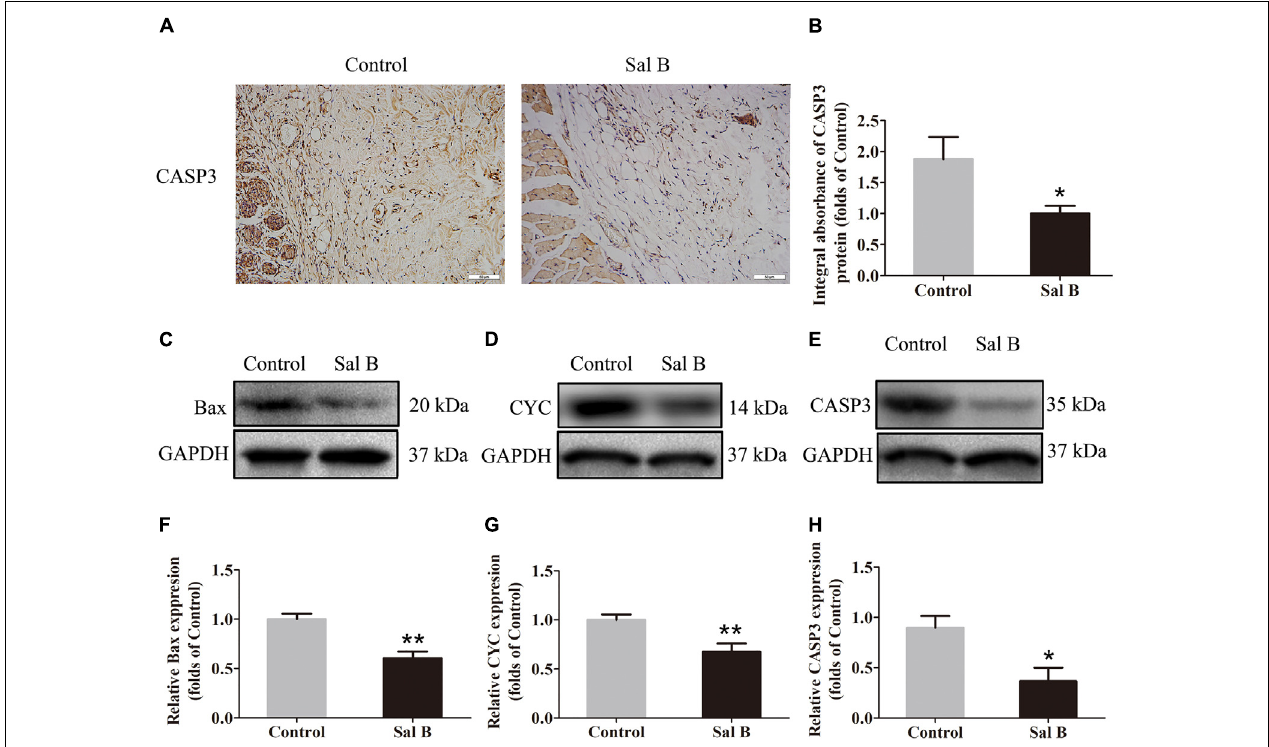
FIGURE 3 | Sal B inhibits apoptosis in random skin flaps. Rats were killed and the samples in middle part of flap area II were harvested for analysis on post-operative day 7. (A) Caspase 3 expression in skin flaps of the Control and Sal B groups, evaluated by IHC (original magnification: 200 × ; scale bar: 50 µ m). (B) Histogram of optical density values of Caspase 3 expression by IHC. (C – E) Western blotting for protein levels of Bax, CYC, and caspase 3, respectively, corrected by GAPDH as internal control. The gels have been run under the same experimental conditions. The original images are available in Supplementary Figure S1B . (F – H) Histograms of optical density values of Bax, CYC, and caspase 3 as determined by Western blotting. ∗ p < 0.05 and ∗∗ p < 0.01 vs. the control group. Data are means ± SEM ( n = 6 per